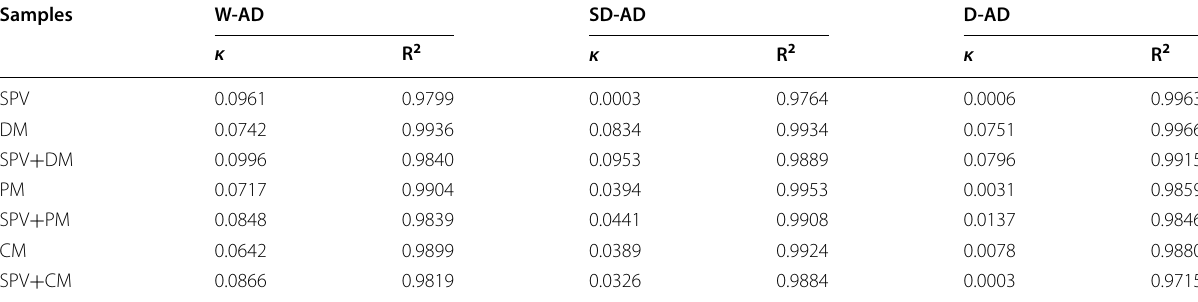
Table 4 Parameters of modified first order model from different mixtures of SPV and animal manure in various anaerobic